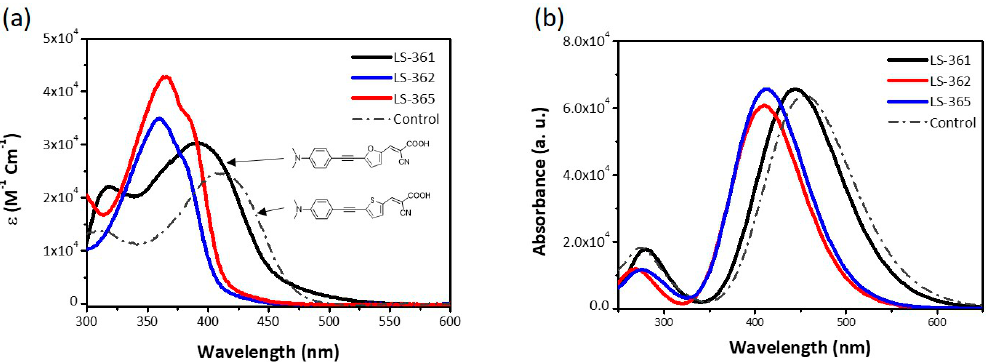
Figure 1. ( a ) UV-vis absorption spectra of Control, LS-361 , LS-362 , and LS-365 dyes in dimethylformamide (DMF) solution (1.5 × 10 − 5 M) and ( b ) their calculated absorption spectra at CAM-B3LYP/6-311++G (d,p) level of the theory under acetonitrile using PCM.